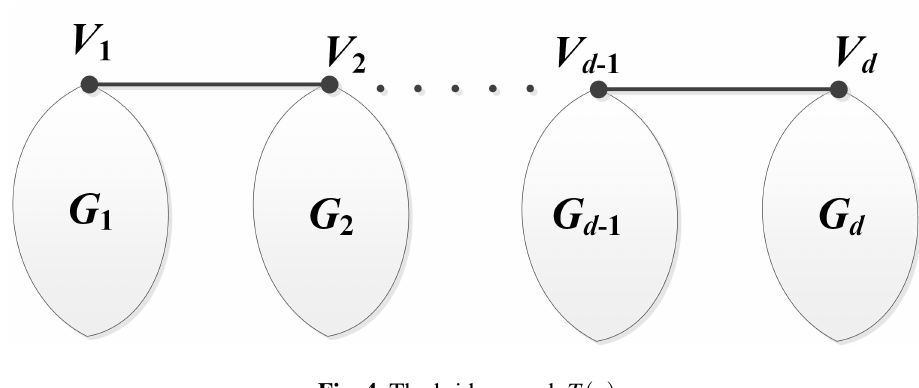
Fig. 4 The bridge graph T ( n